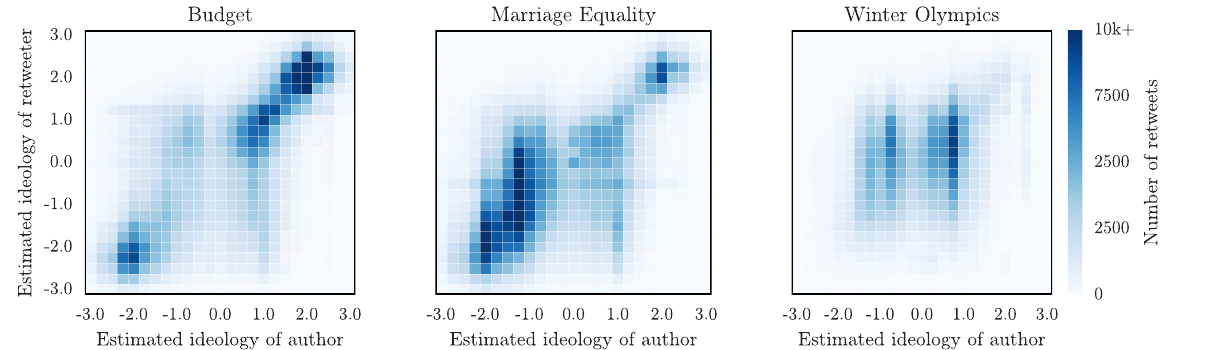
Figure 1. Debates and echo chambers on Twitter. Shown is the number of retweets according to the inferred ideologies of the author and of the retweeter. The ideology of authors is estimated through their connections and ranges from strongly liberal ( − 3) to strongly conservative ( + 3). Political subjects such as the federal budget and marriage equality in the USA (left and middle panels respectively) lead to a much stronger homophily and the creation of echo chambers, while non-political subjects such as the 2014 Winter Olympics (right panel) are not polarized. Reproduced from Ref.